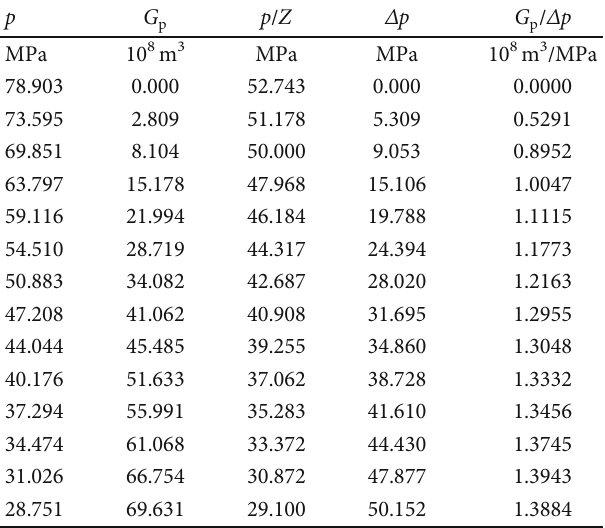
Figure 5: Reserves of Anderson “ L ” gas reservoir calculated by the p / Z curve method. Table 3: Producing history of Louisiana o ff shore gas reservoir (Ramagost, 1981).